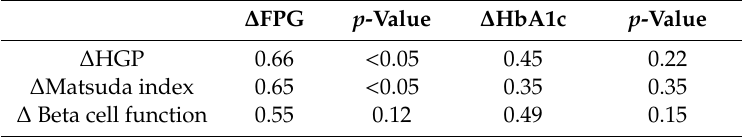
Table 2. Correlation Analysis (Spearman Correlation Coe ffi cients).